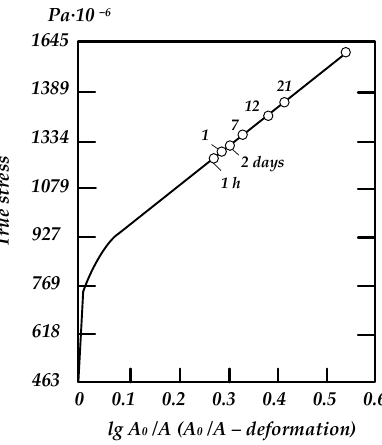
Figure 4 from this work shows the deformation curve (dependence of the true stress on the true relative deformation ε ) of chromium-molybdenum steel after improvement. The end points of deformation are plotted on the curve, corresponding to the values of the true breaking stress S K of the samples, pre-saturated with hydrogen up to 5 × 10 − 5 m 3 /kg (saturation temperature 873 K, increased hydrogen pressure, exposure to hydrogen for 2 h), and kept at room temperature for different times (from 1 h to 21 days).